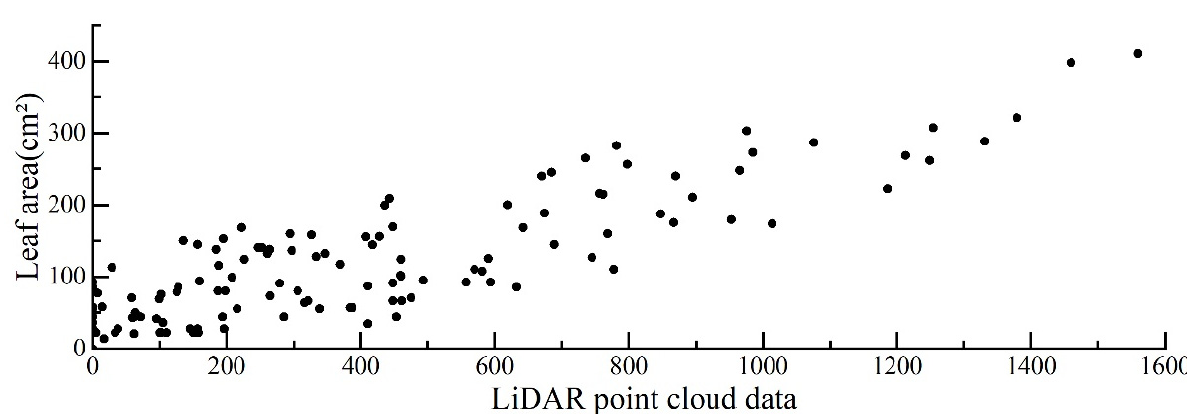
Figure 9. The residual values after seventeen iterations.